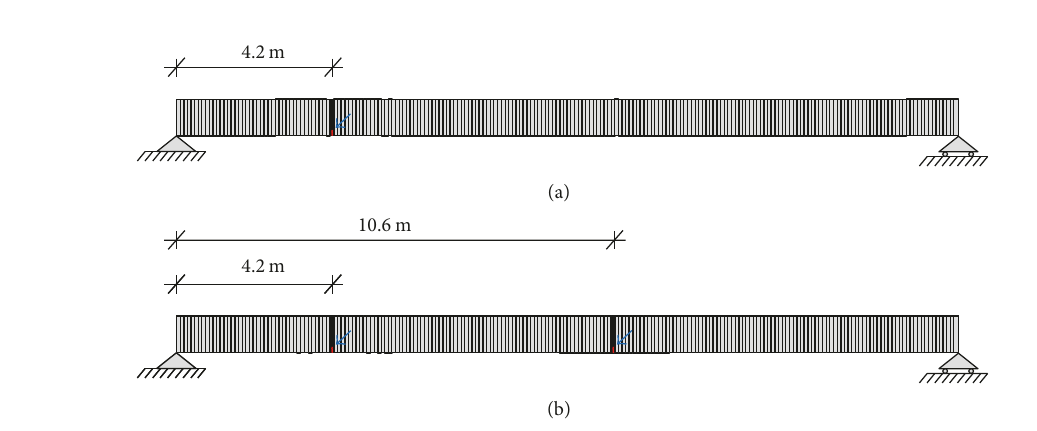
Figure 2: Damage scenarios: (a) single damage case and (b) multiple damage